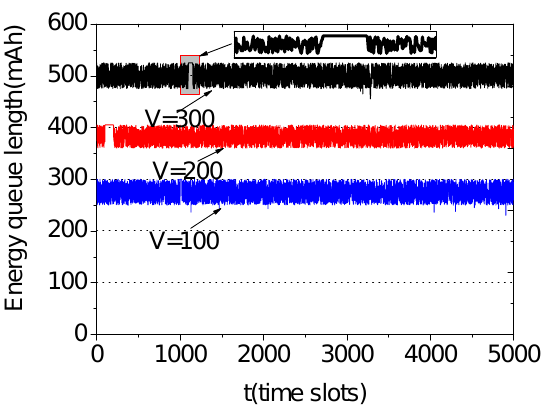
Figure 4. Energy queue